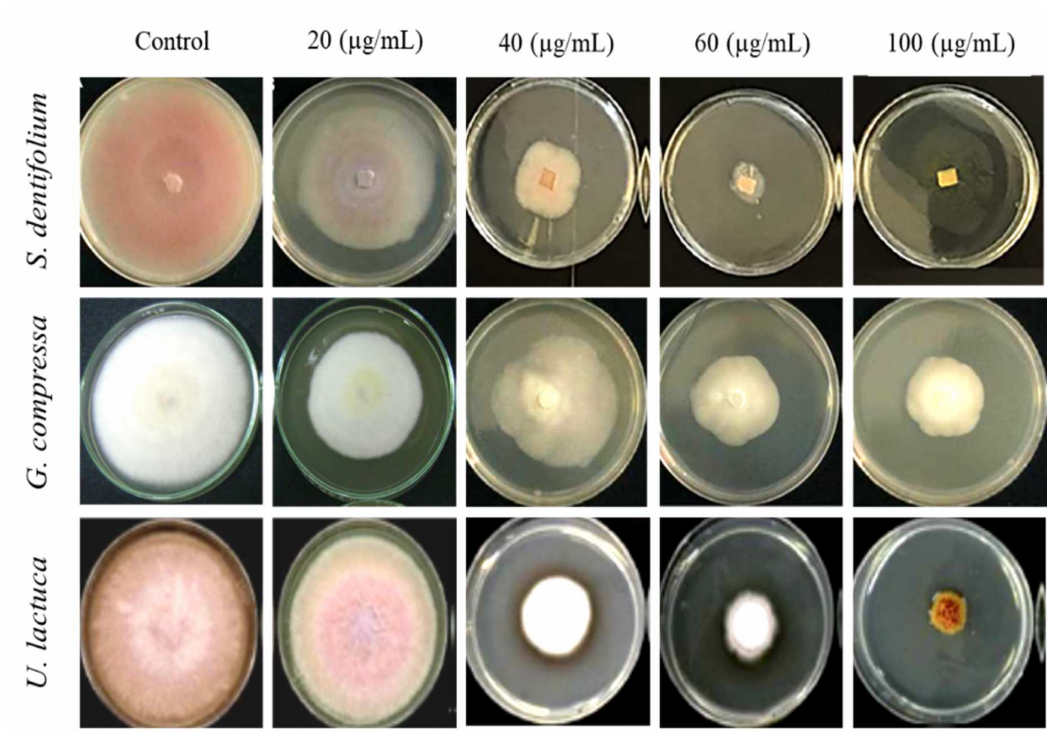
Figure 5. Antifungal activity of microalgae methanol extracts against FOL at different concentrations.